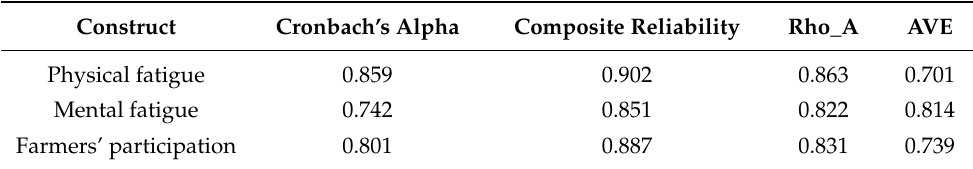
Table 3. Individual item reliability and validity.